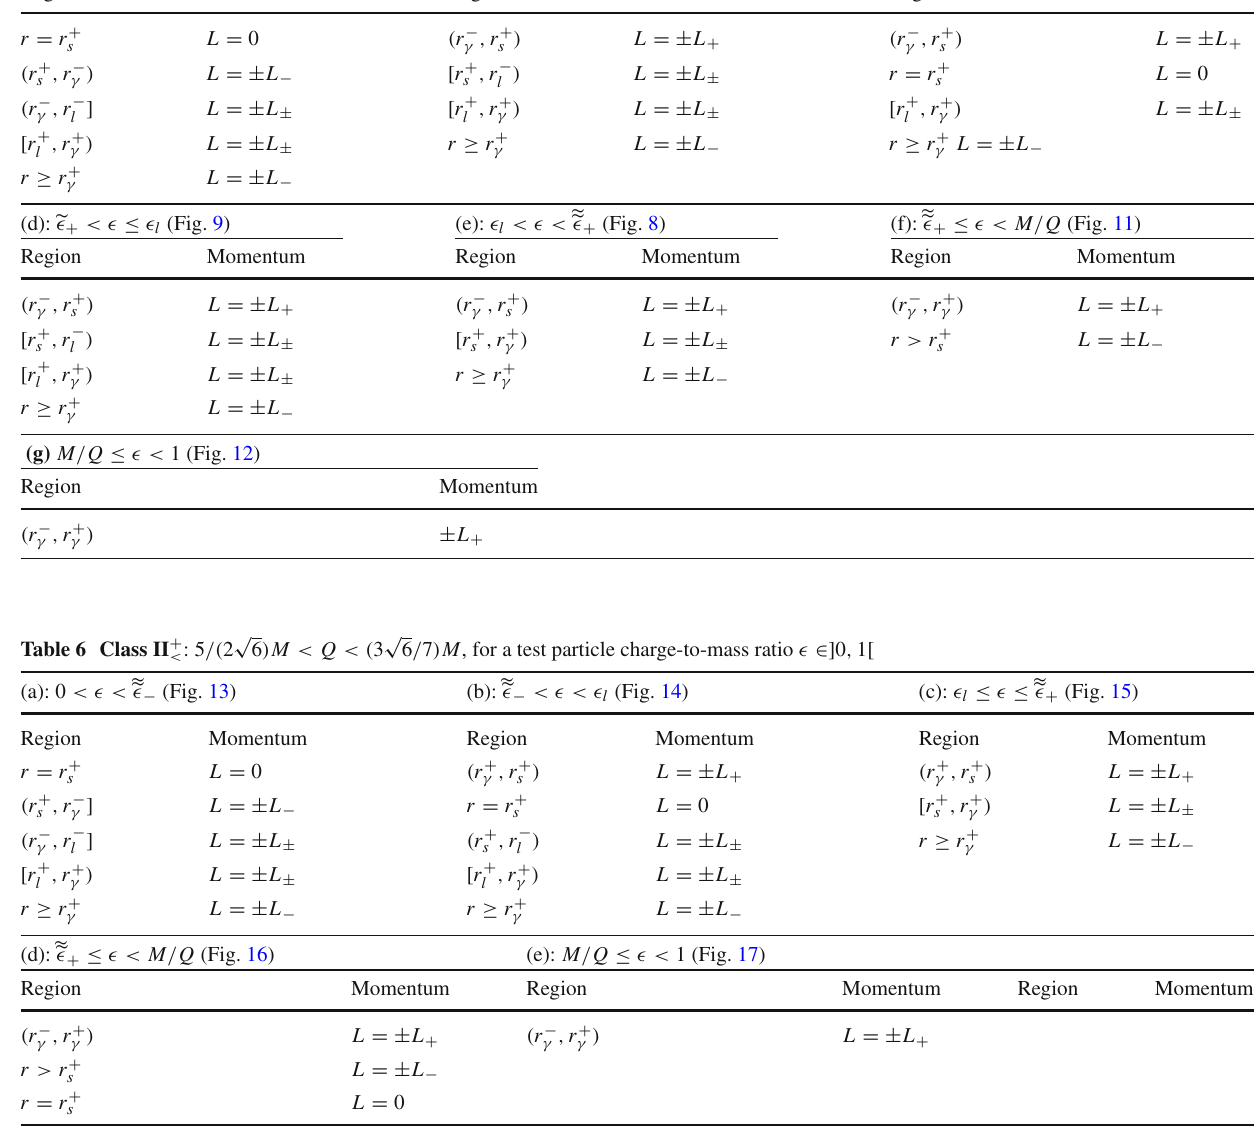
√ 6 ) M for a test particle charge-to-mass ratio (cid:2) ∈] 0 , 1 [